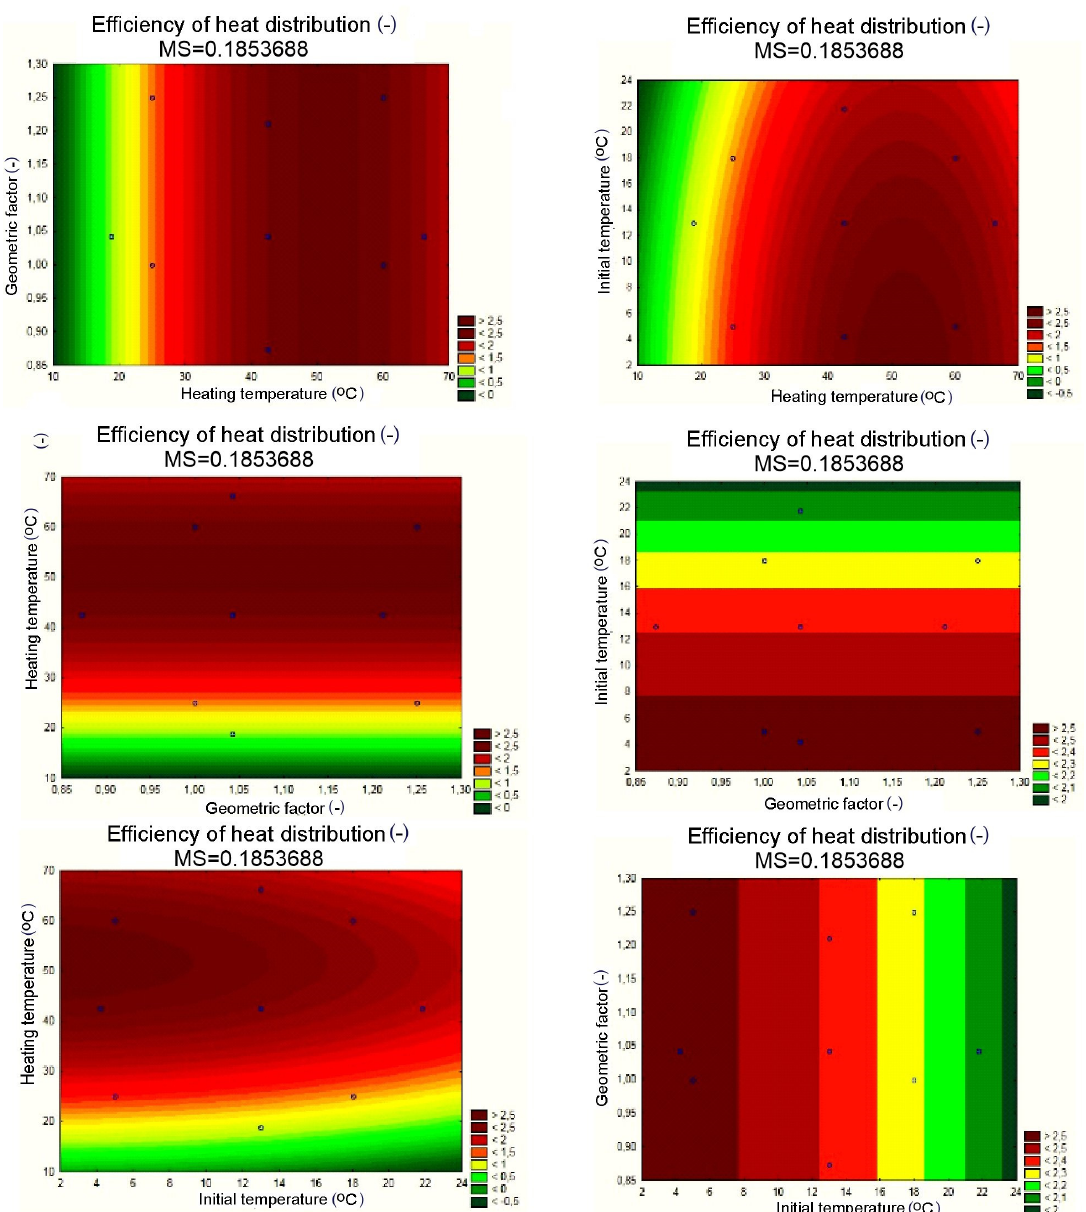
Figure 17. Results of the analysis of the effect of statistically significant input quantities on the response function value, applicable to the PCM/copper conductor heat accumulator.